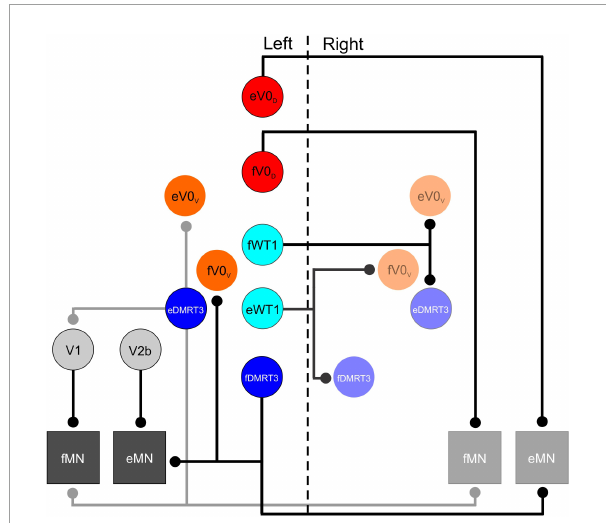
FIGURE1 Schematic of synaptic contacts from inhibitory interneuronal populations in the lumbar spinal cord that are involved in locomotion. Vertical dashed line separates left and right side of spinal cord. In this schematic all inhibitory populations that have a defined role during locomotor activity appear on the left side, only those populations that receive inputs from these cells appear on the right side. Motoneurons are shown on both sides. Lowercase f and e indicate those members of a given population that are active during flexion and extension